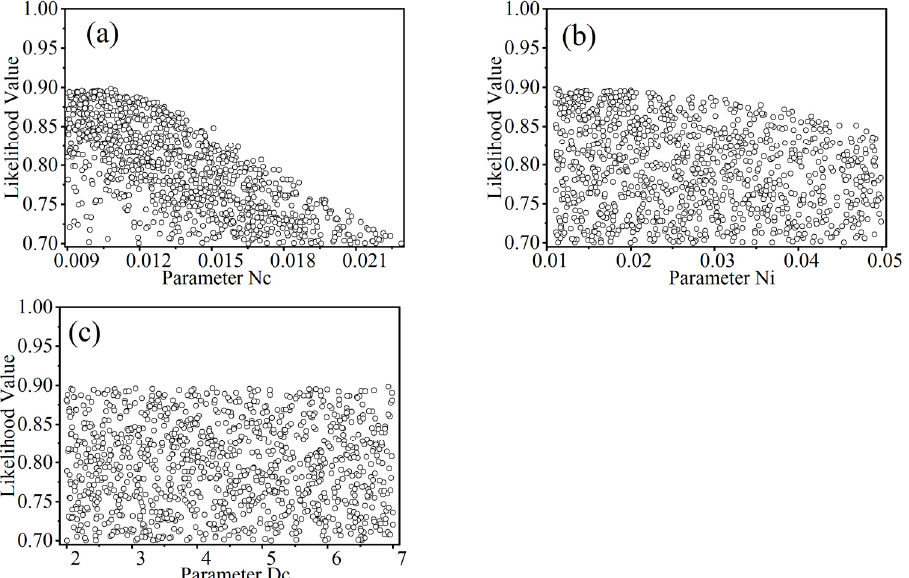
Figure 4. Likelihood scatters plot of parameters: ( a ) Relationship of parameter Nc and NSE; ( b ) Rela-